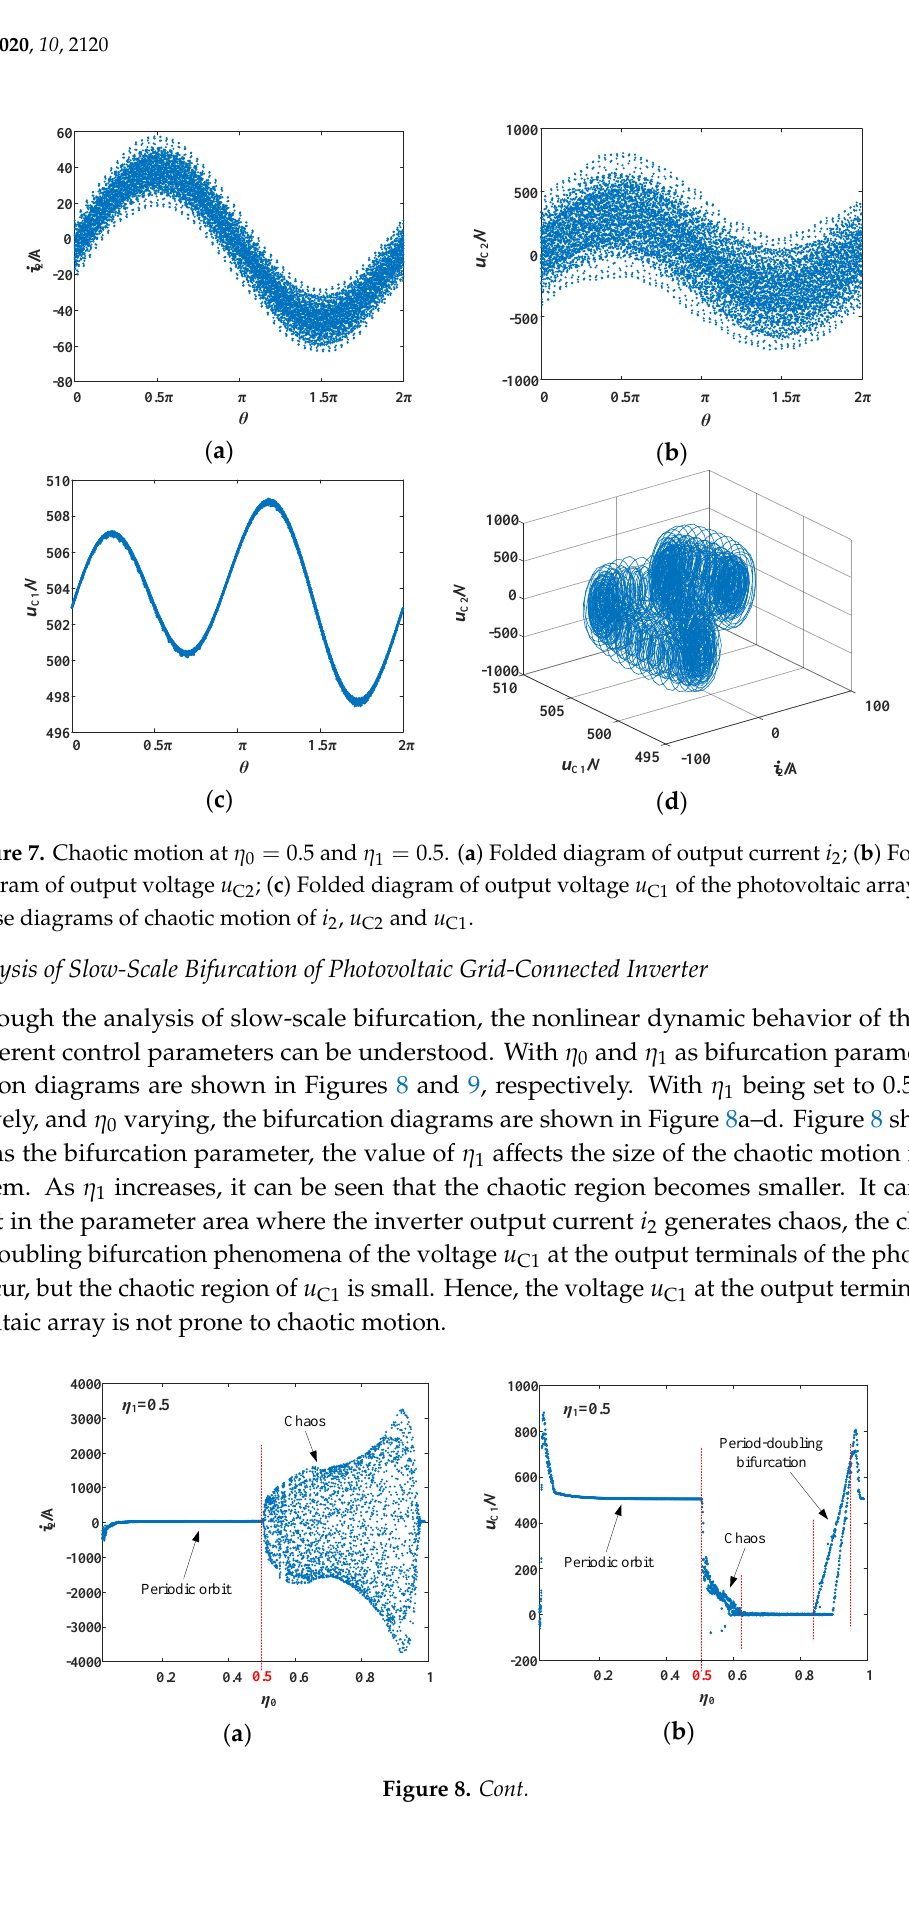
Figure 6. Quasiperiodic motion at 𝜂 0 = 0.5 and 𝜂 1 = 0.9 . ( a ) Folded diagram of output current 𝑖 2 ; ( b ) Folded diagram of output voltage 𝑢 C2 ; ( c ) Folded diagram of output voltage 𝑢 C1 of the photovoltaic array; ( d ) Phase diagram of quasi-periodic motion of 𝑖 2 , 𝑢 C2 , and 𝑢 C1 .